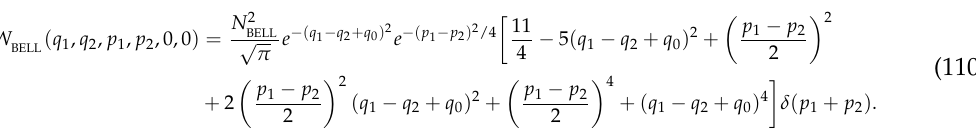
is that it BELL / N 2 BELL BELL